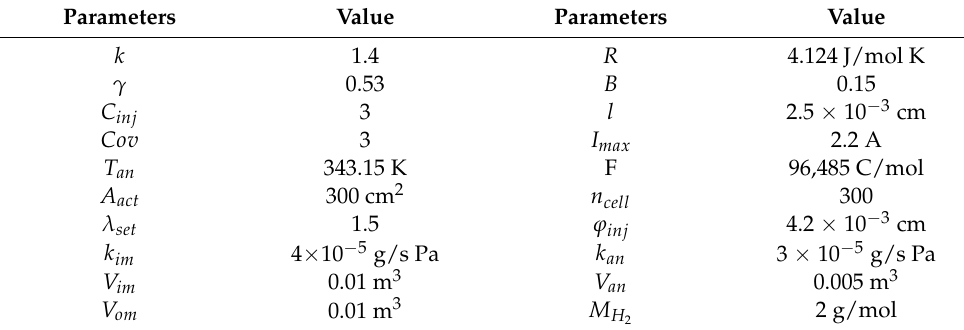
Table 2. Operating parameters of the hydrogen system. Parameters Value